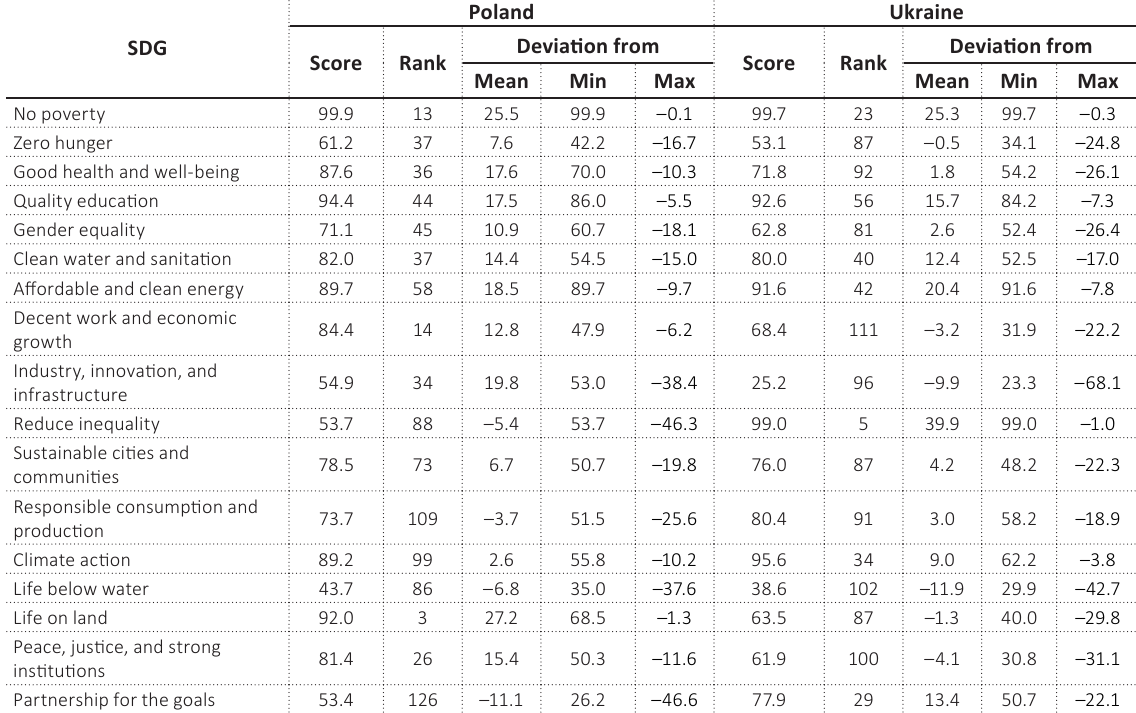
Table 1. Summary statistics for SDGs in Poland and